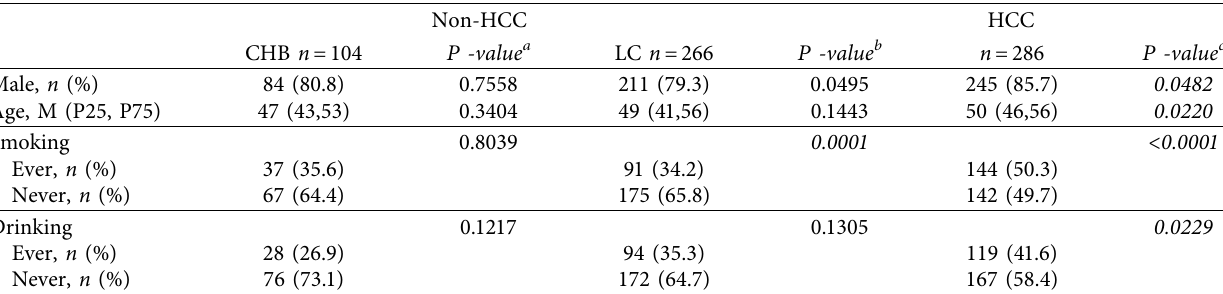
Table 3: Baseline characteristic of chronic HBV infection